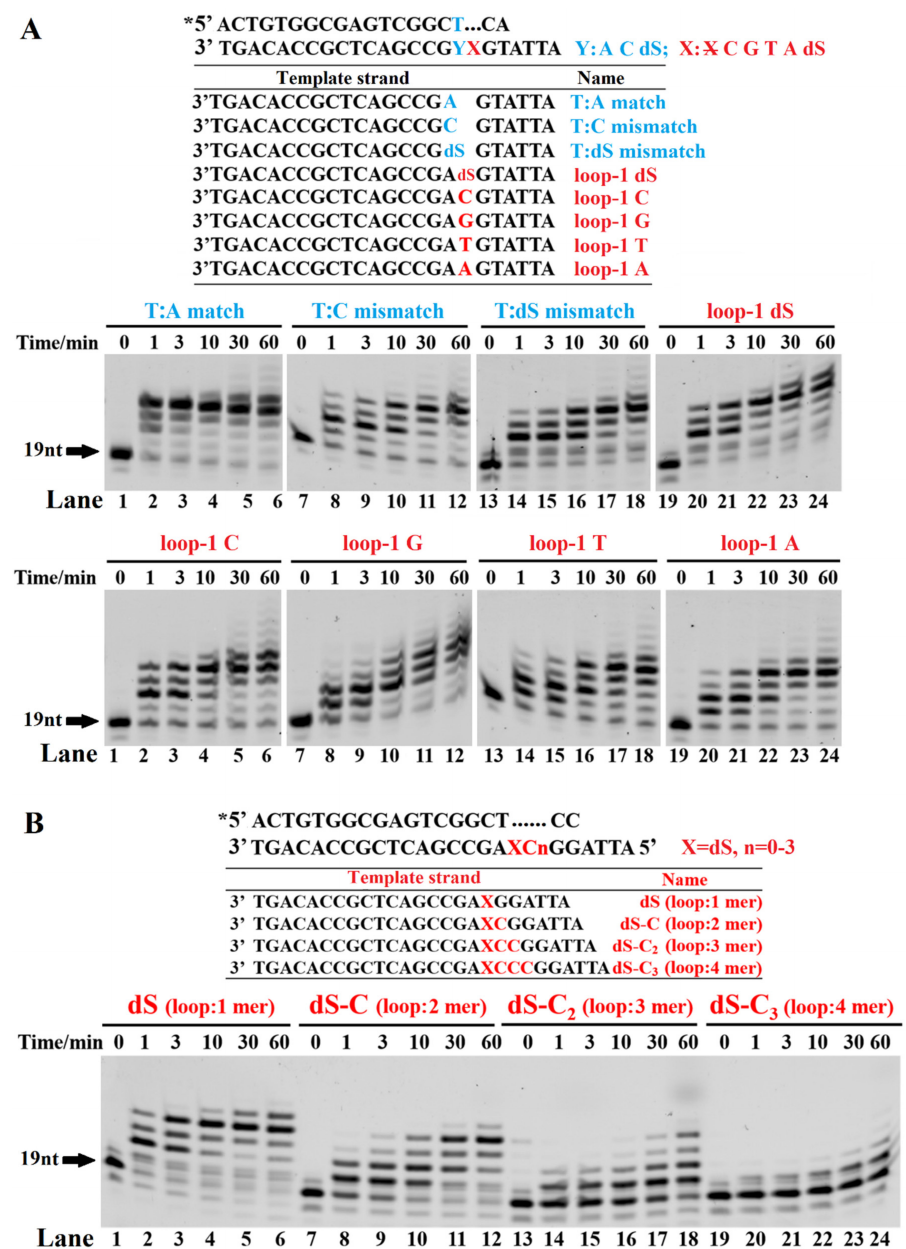
Figure 5. Effect of the bulging loop on TLS. The PT DNA substrates are shown at the top of the figure, where the letter X denotes bases A, T, C, G, and dSpacer, and the letter Y denotes bases A, C, and dSpacer. The symbol X denotes without spacer or base. ( A ) Effect of the base mismatches (T:C mismatch and T:dS mismatch) and a bulging base loop or dSpacer loop (1-mer loops of dS, C, G, T, and A) on TLS efficiency. ( B ) Effect of the size of the bulging loop (dS, dS-C, dS-C 2 , and dS-C 3 ) on TLS efficiency. The PT DNA substrates were incubated with 0.1 µ M Dbh and dNTPs at 45 ◦ C for 0, 1, 3, 10, 30, and 60 min. Asterisks denote the terminal fluorescent group